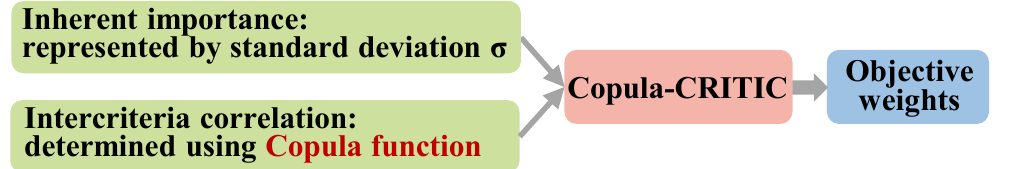
Figure 3. The Copula ‐ CRITIC method for objective weighting.